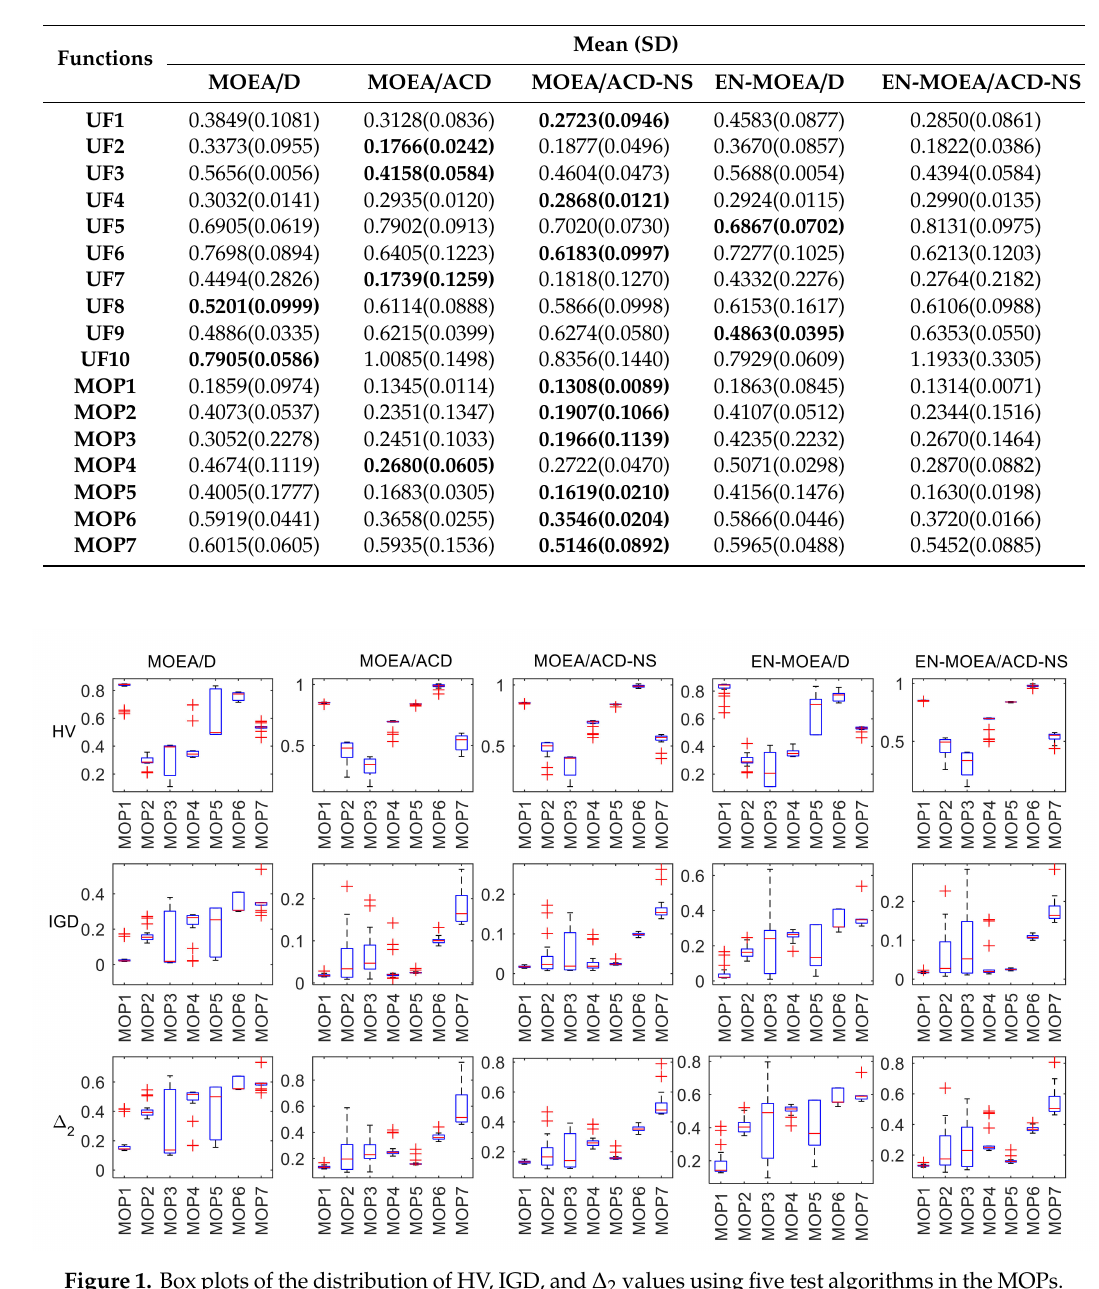
Table 3. Statistical results of ∆ 2 metric values obtained by MOEA / D, MOEA / ACD, MOEA / ACD-NS, EN-MOEA / D, and EN-MOEA / ACD-NS (mean and SD). The bold number is the optimal value of each set of functions.